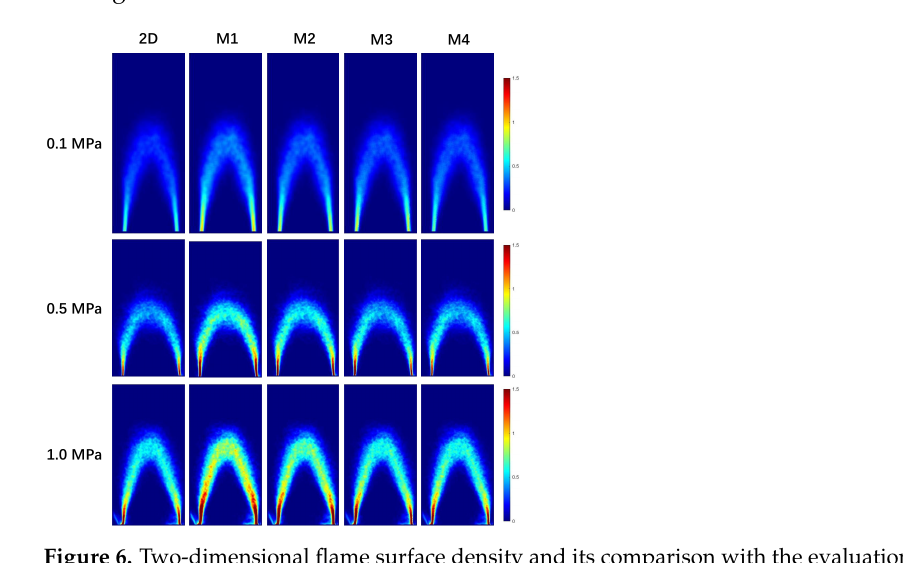
Figure 6. Two-dimensional flame surface density and its comparison with the evaluation by M1~M4. Upper panel: 0.1 MPa; middle panel: 0.5 MPa; lower panel 1.0 MPa.